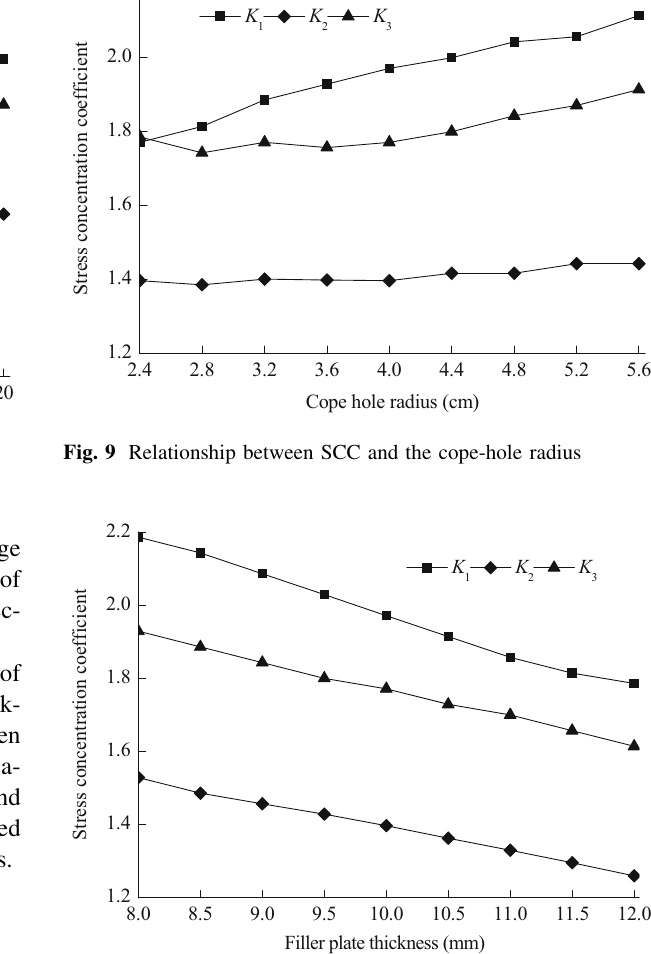
Fig. 10 Relationship between SCCs and the filler plate